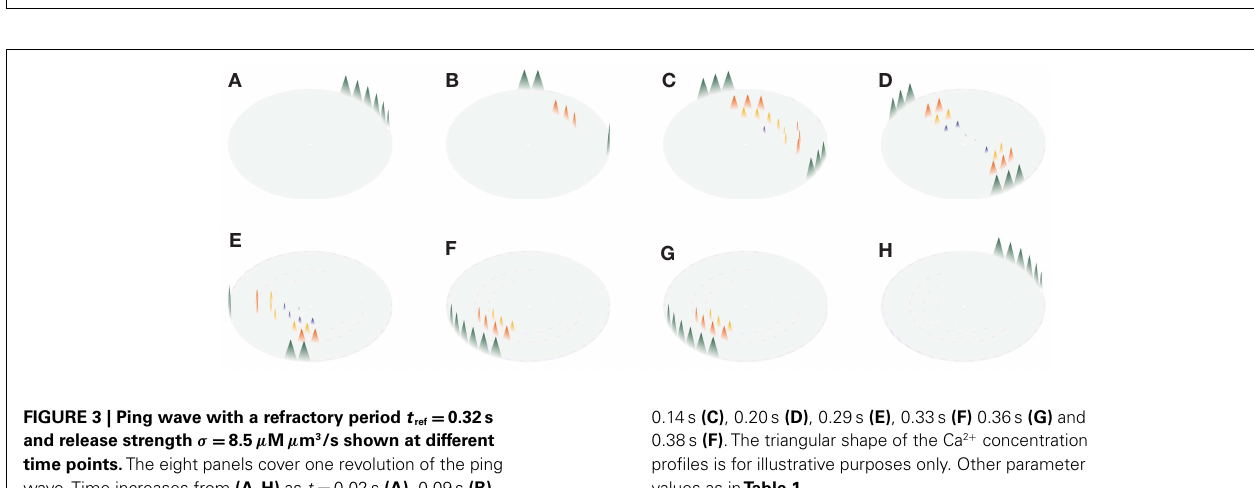
FIGURE 2 | Paced myocyte with an initial fraction of 0.2 for different combinations of release strength and refractory period: σ = 15 µ M µ m 3 /s, t ref = 1.4s (A), σ = 15 µ M µ m 3 /s, t ref = 1s (B), σ = 13 µ M µ m 3 /s, t ref = 1s